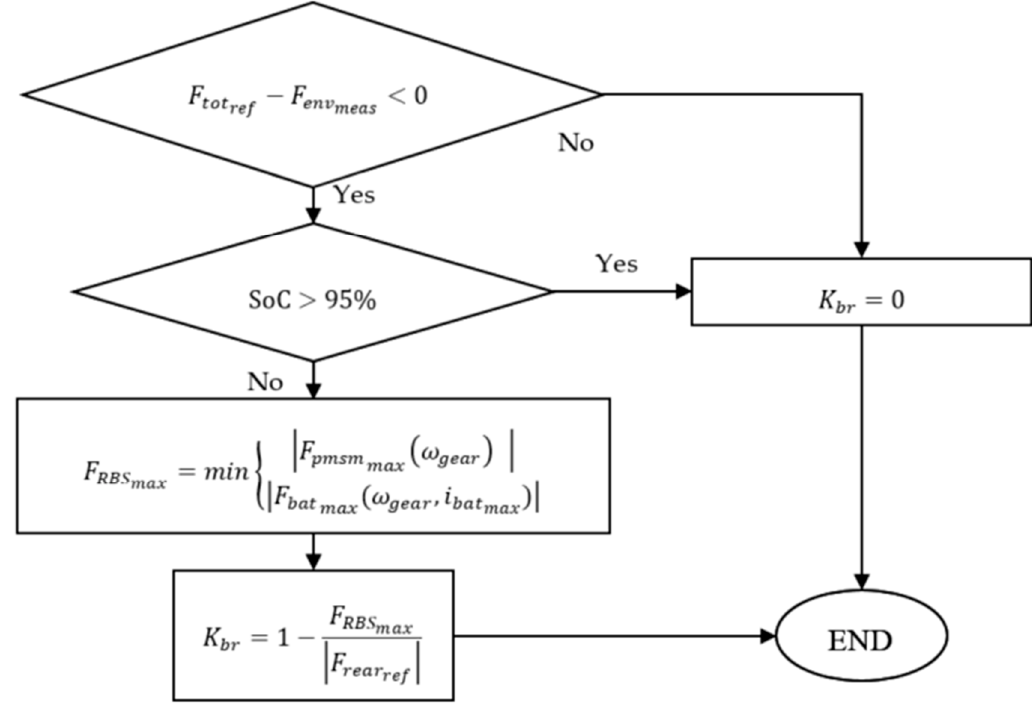
Figure 8. Decision of RBS and FBS contribution coe ffi cient K br .